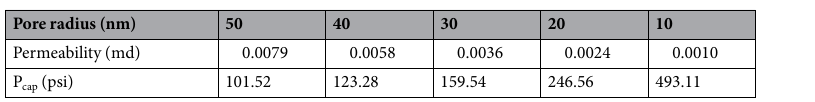
Table 4. Permeability and capillary pressure under different pore sizes.